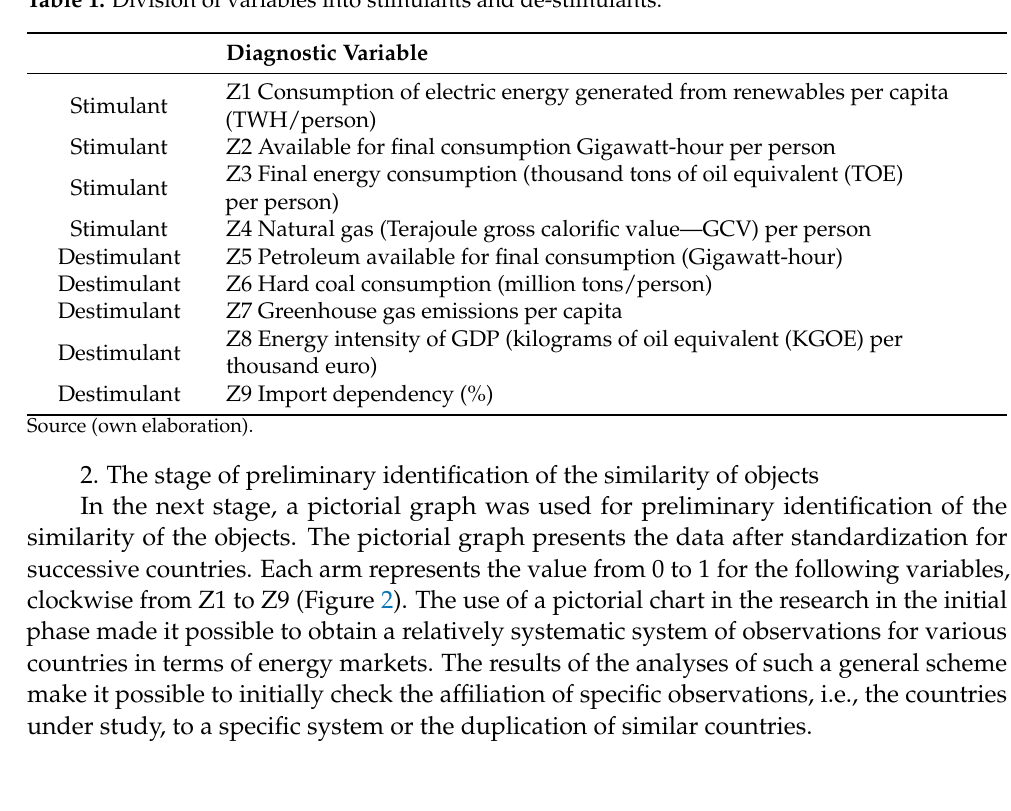
Table 1. Division of variables into stimulants and